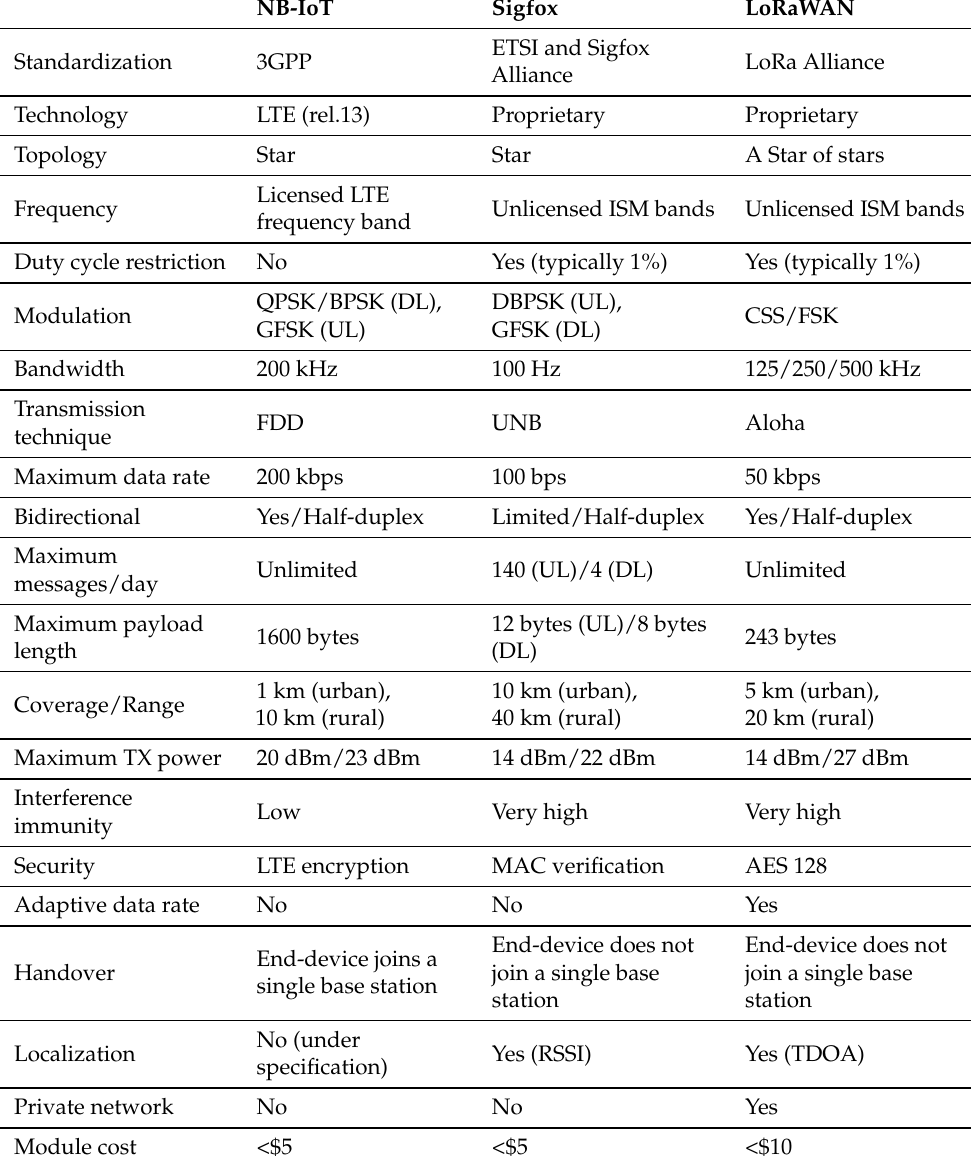
Figure 2. Wireless technologies categorized according to their data rate and coverage. Table 1. Comparison of various